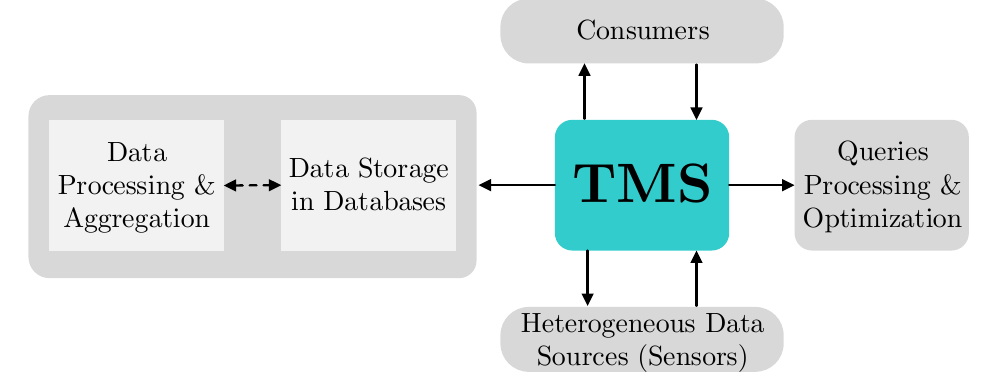
Figure 2. Overall architecture of a modern traffic management